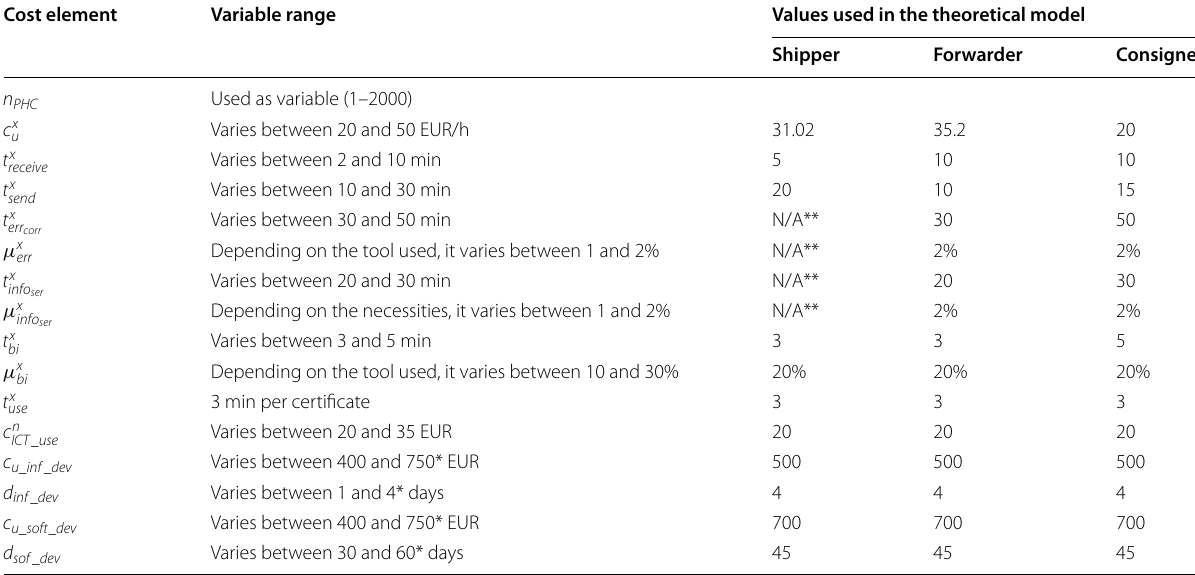
Table 3 Cost elements are used in the cost calculation. Source : personal interviews with representatives of supply chain stakeholders and blockchain